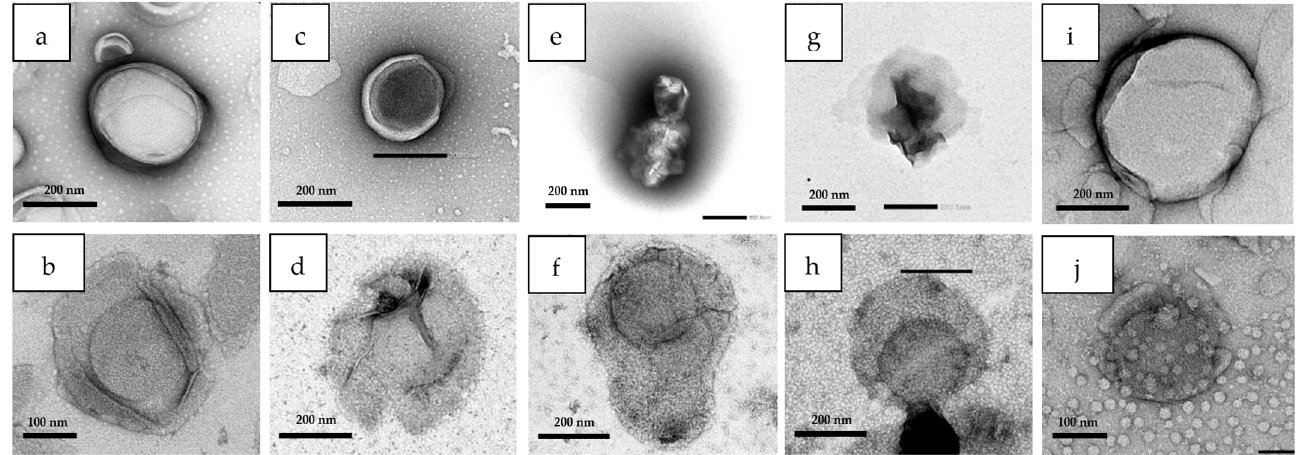
Figure 8. TEM images ( a ) SGC-Lip in SGF, ( b ) ES100-SGC-Lip in SGF, ( c ) SGC-Lip in FaSSIF, ( d ) ES100-SGC-Lip in FaSSIF, (e) SGC-Lip in FeSSIF, ( f ) ES100-SGC-Lip in FeSSIF, ( g ) Lip in FeSSIF, ( h ) ES100 -Lip in FeSSIF, ( i ) SGC-Lip in PBS pH 7.4, ( j ) ES100-SGC-Lip in PBS pH 7.4 after 2-h incubation at 37 °C.